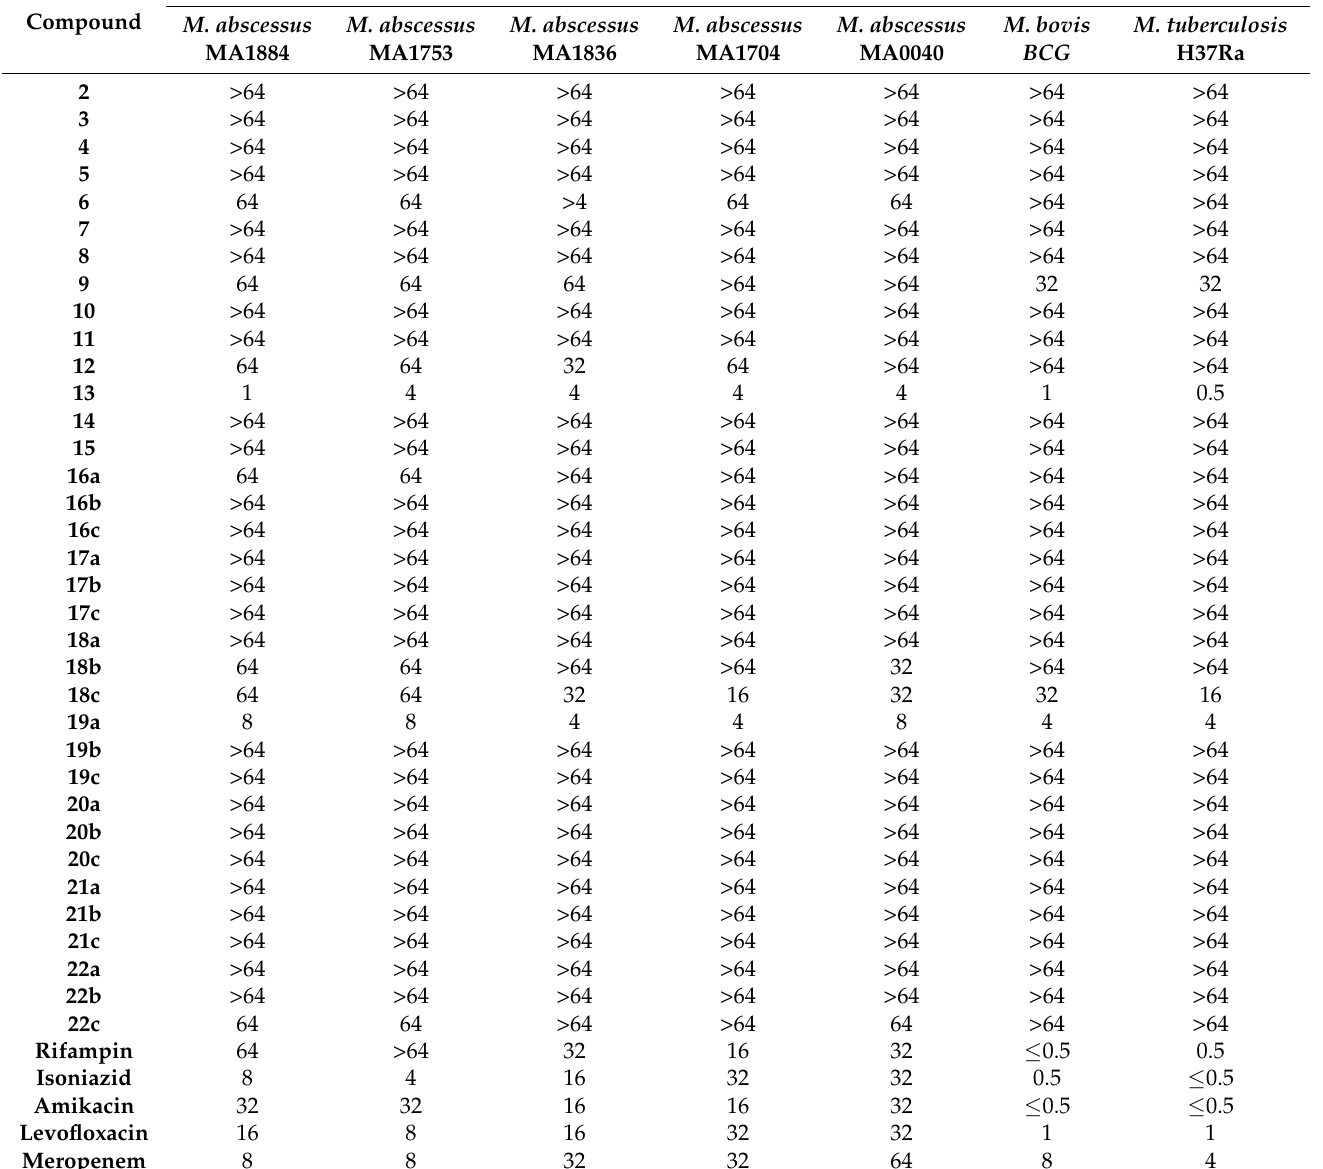
Table 1. The in vitro antimicrobial activity of compounds 2–22a–c against mycobacteria. The min- imal inhibitory concentration (MIC) values are provided as an average value obtained from three experimental